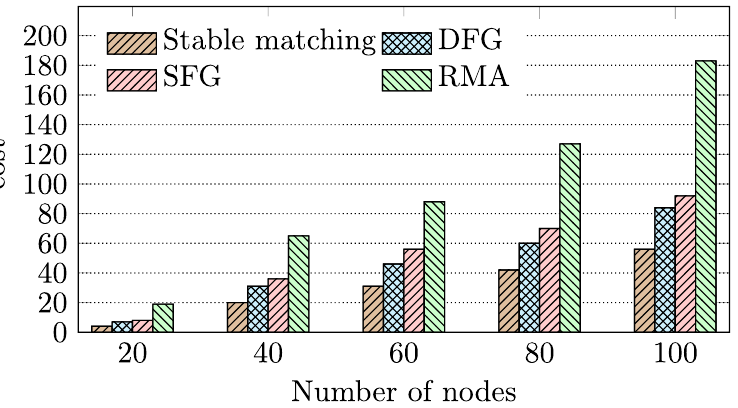
Figure 4. System costs of 4 matching algorithms with different numbers of